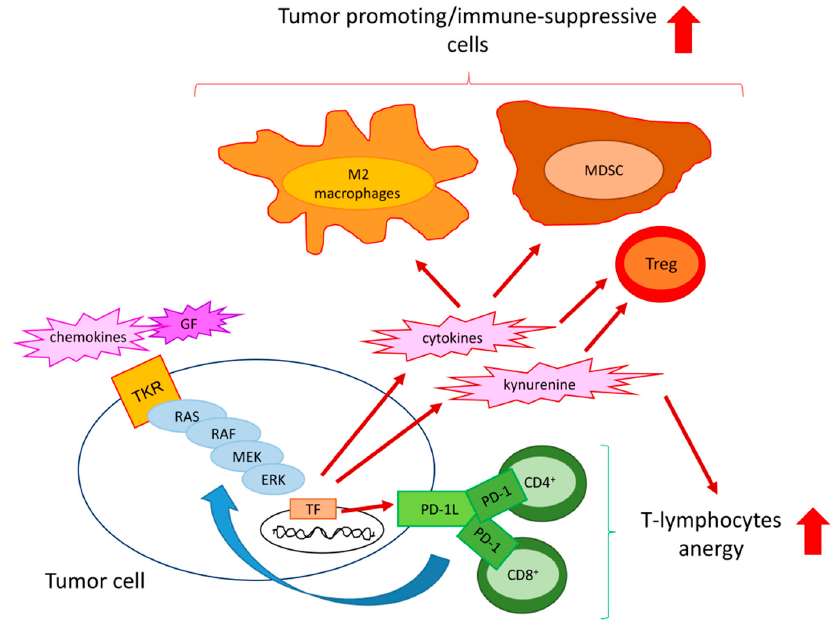
Figure 2. Mechanisms of ERK-induced immune-resistance or immune-escape. In response to chemokines and growth factors (GFs), specific tyrosine kinase receptors (TKR) activate the RAS/RAF/MEK/ERK axis and the down-stream transcription factors (TF) in tumor cells. As a result, cancer cells produce immune-suppressive cytokines [e.g., interleukin (IL)-10 and transforming growth factor- β (TGF- β )] and metabolites (e.g., kynurenine) that reduce the proliferation of effector CD4 + and CD8 + T-lymphocytes and expand tumor-promoting/immune-suppressive cells, such as M2-polarized macrophages, myeloid derived suppressor cells (MDSC), and T-regulatory (Treg) cells. The RAS/RAF/MEK/ERK axis also up-regulates the immune-checkpoint ligand programmed death-1 ligand (PD-1L), which expands PD-1 rich/anergic CD4 + and CD8 + T-cells and fuels ERK activity with a positive feedback mechanism. Exploiting these multiple strategies, ERK activation in tumor cells contributes to create a tumor-promoting/immune-suppressive environment.